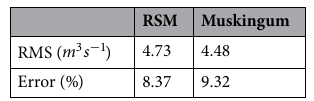
Table 2. Calibration results for the Wilson event.